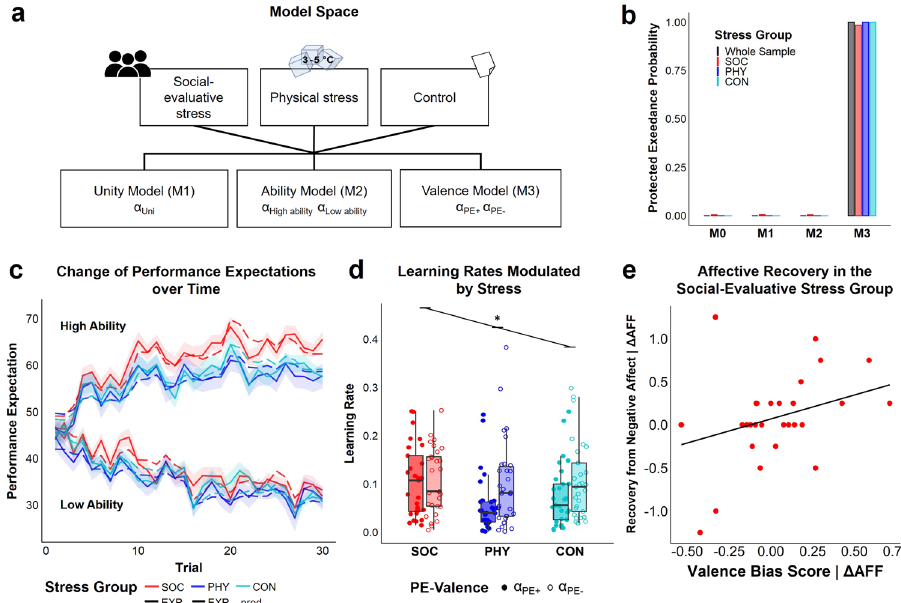
Figure 3. ( a ) Structure of the model space. α Uni = one learning rate for the whole time course; α High ability / α Low ability = two separate learning rates for the two ability conditions; α PE+ /α PE- = two separate learning rates for positive and negative prediction errors; adapted from Müller-Pinzler et al. 21 . ( b ) Protected exceedance probabilities resulting from the Bayesian Model Selection procedure including the prediction error learning models depicted in (a) and a mean model (M0) assuming stable means for each ability condition instead of continuous learning ( c ) Performance expectation ratings (EXP, solid line) and performance expectations predicted by the winning model (EXP − pred., dashed line) over the time course of 30 trials. Ratings and predicted values were averaged across participants separately for the two ability conditions and the three experimental groups. Shaded areas represent the standard errors of the expectation ratings for each trial. ( d ) Learning rates derived from the Valence Model (winning model). A significant interaction effect (*) of PE-Valence x Stress group (SOC = social-evaluative stress, PHY = physical stress, CON = no stress control) indicates that a bias towards increased updating in response to negative prediction errors (α PE- ) in contrast to positive prediction errors (α PE+ ) is absent in the social-evaluative stress group. ( d ) Rank-based regression plot of valence bias score predicting the recovery from negative affect (REC, ratings T2 AFF − T3 AFF ) in the subsample of the social-evaluative stress group (n = 29) controlled for the stress-induced change in negative affect (ΔAFF, ratings T2 AFF − T1 AFF ), i.e., residuals of the valence bias score and the recovery predicted by ΔAFF are plotted. More self-beneficial belief updating (higher valence bias score) is associated with a better recovery from stress- induced negative